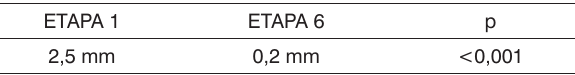
Tabela 2. Comparação das médias entre as etapas 1 (sem o siste- ma; tesoura parada) e 6 (com o sistema; tesoura na lateral direita; fio afrouxado em 3 mm).